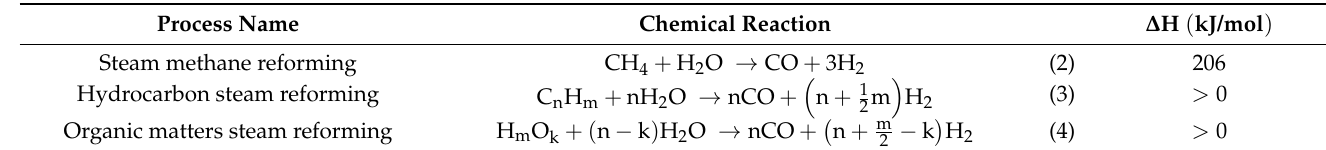
Table 3. Main hydrocarbon reforming chemical